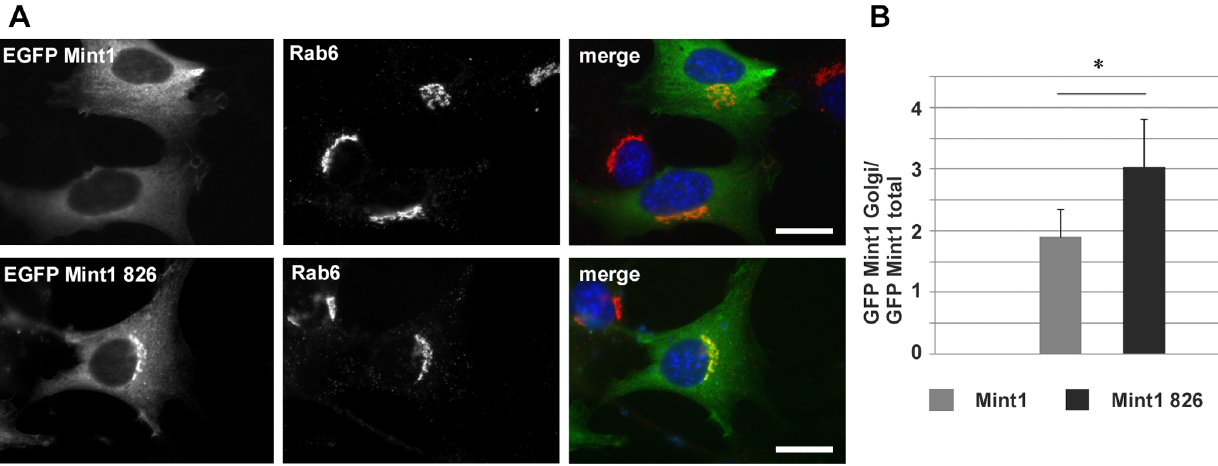
Figure 8. Intracellular distribution of Mint1 826 and Mint1. 3T3 Swiss cells were transiently transfected with either pEGFP Mint1 826 or pEGFP Mint1. 24 h after transfection cells were fixed and co-stained with a Rab6A specific antibody (5B10), which was conjugated with OY594 directly. A) Co-localization studies of endogenous Rab6A with EGFP Mint1 826 or EGFP Mint1, respectively. B) Quantitative analyses of the cellular distribution of Mint1/Mint1 826. Cells from two independent experiments were evaluated with the Cell ‘ F software (Olympus) by calculating the ratio between the average gray value of Mint1 at the Golgi apparatus and the average gray value of Mint1 in the total cell. Statistical significance was tested via student’s t-test,